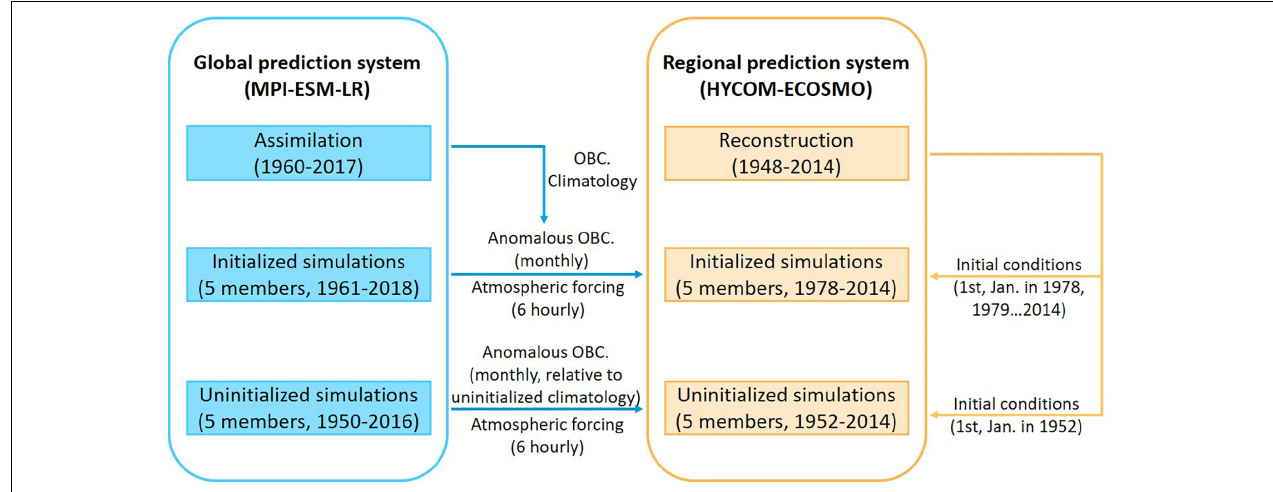
FIGURE 3 | Schematic diagram describing how the three sets of simulations with the regional prediction system are built. Blue box: Ensembles of initialized and uninitialized simulations from the global prediction system (MPI-ESM-LR) provide 6-hourly atmospheric forcing and monthly anomalous open boundary conditions (OBC) to the corresponding ensembles of initialized and uninitialized simulations with the regional prediction system (HYCOM-ECOSMO). The anomaly fields of the initialized simulations from MPI-ESM-LR are based on the assimilation run, while the anomaly fields of the uninitialized simulations from MPI-ESM-LR are based on their own climatology. Orange box: Reconstruction with HYCOM-ECOSMO provides initial conditions for the initialized and uninitialized simulations within the same regional prediction